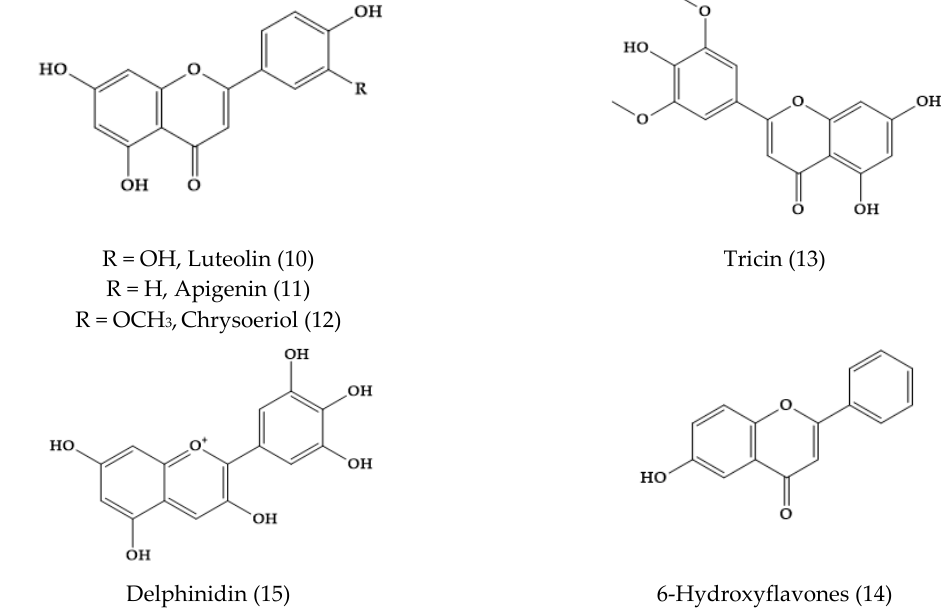
Figure 2. Common flavonoid aglycones in several Veronica species.